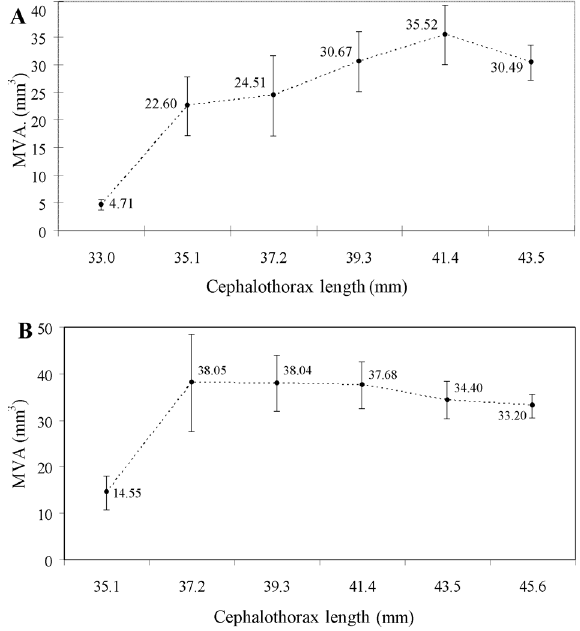
Figure 5. Relationship between mean abundance of cysts of Mi- crophallus nicolli calculated from volumetric measurements and the cephalothorax length of females of Emerita rathbunae . Data are from only San Andrés ( A ) and Las Trancas beaches ( B ).